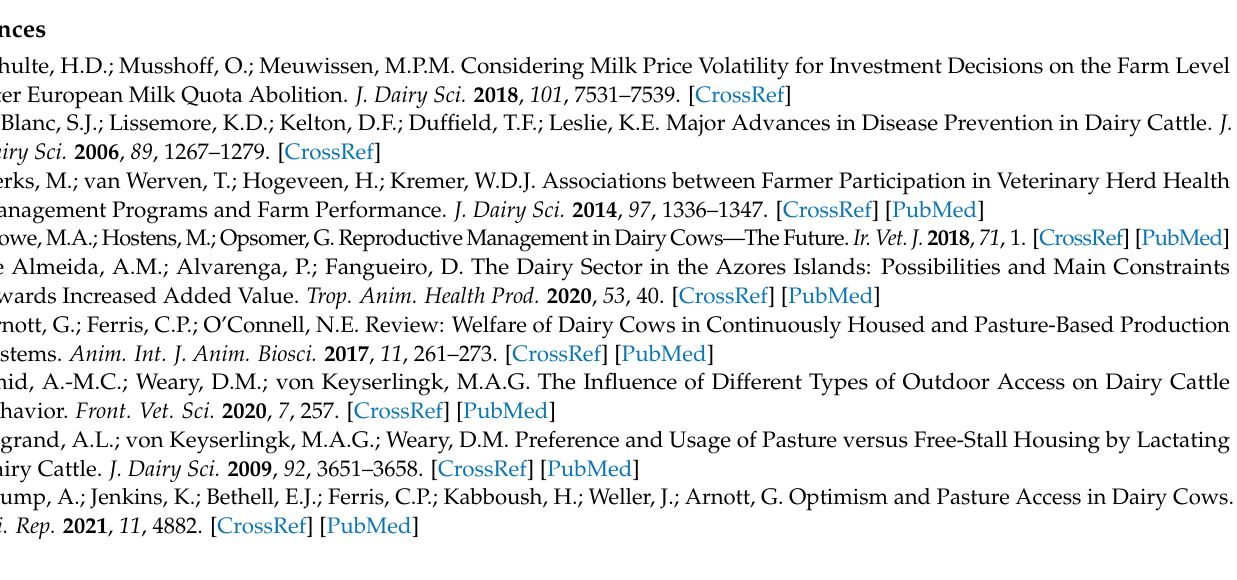
Table S3. Lameness and lameness control in dairy farms with fixed (FMP) versus mobile (MMS) milking systems. Table S4. Dry-off time and prepartum measures adopted in dairy farms with fixed (FMP) versus mobile (MMS) milking